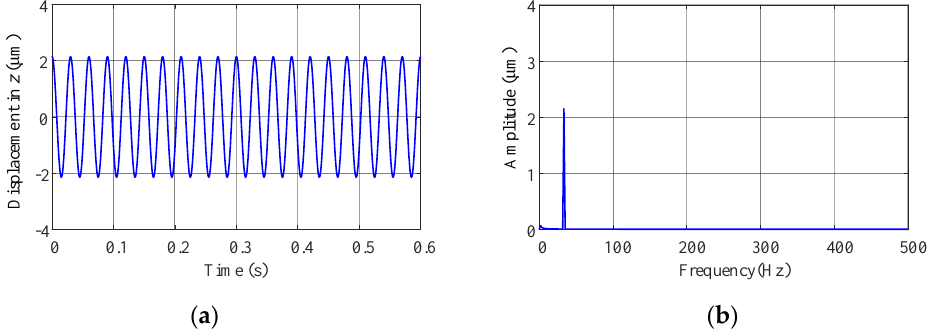
Figure 6. Response of high-pressure rotor at low speed. ( a ) time domain response; ( b ) frequency domain response.